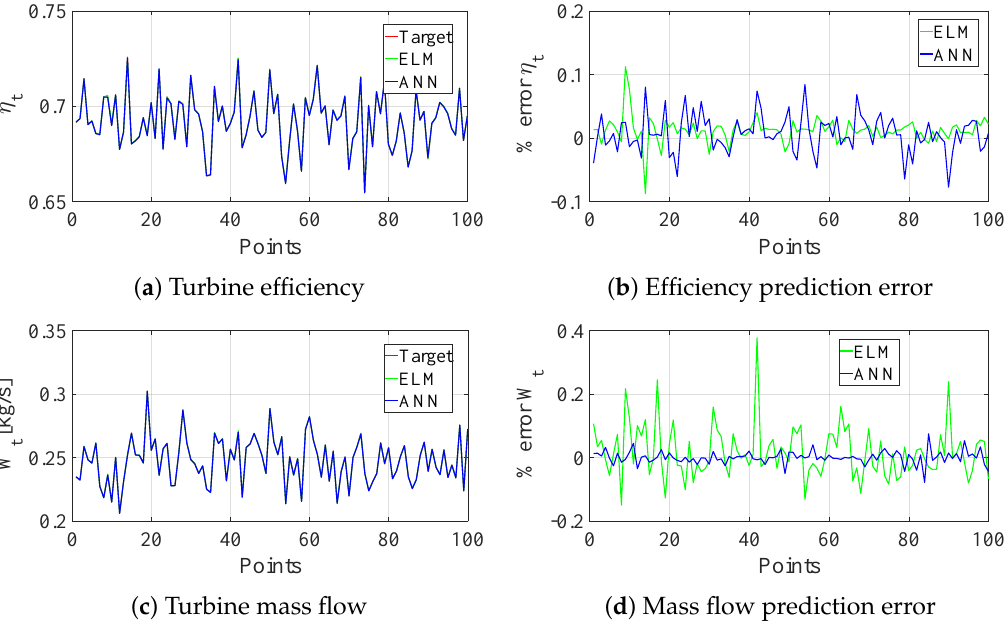
Figure 13. Turbine degradation in flight regime 3 with input vector 2: comparison between the target and prediction of the component performance